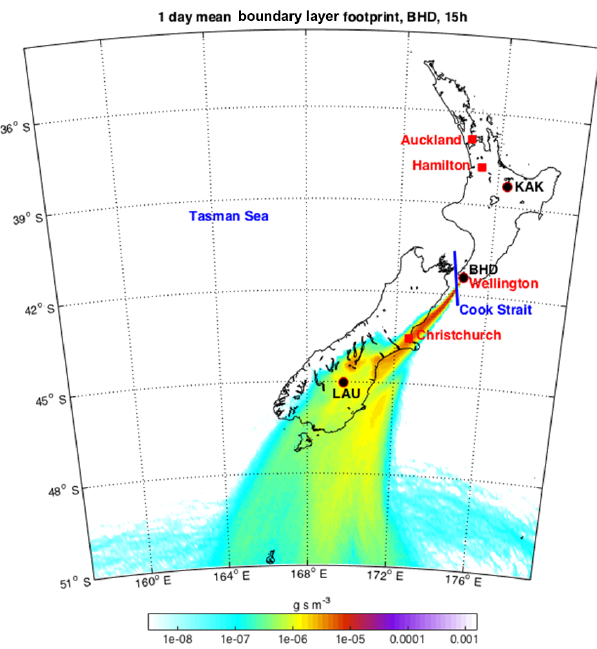
Figure 2. Air history map for 10000 particles released at BHD during 15:00–16:00LT on 19 May 2012 using the NAME III model. The particle back trajectories show a southerly event lo- cally at the station, though not a baseline event as the air crosses parts of South Island. Also shown are the locations of LAU and K¯akaramea/Rainbow Mountain (KAK)